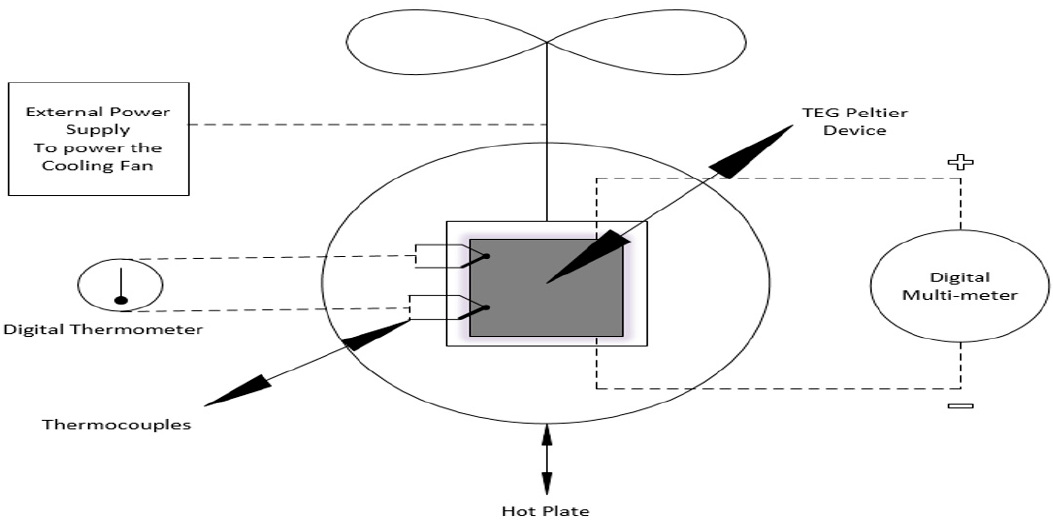
Figure 2. Schematic diagram of the direct heat harvesting method using a hot plate with heat-stove TEG for electrical performance testing. Table 1. Specifications of heat-stove TEG.